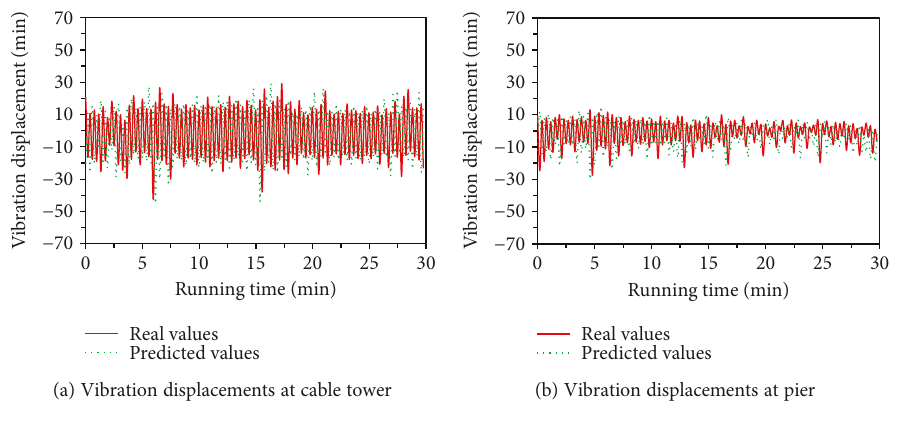
Figure 13: Prediction of PSO-BP neural network model. Table 1: Comparison of predicted results for three kinds of neural network